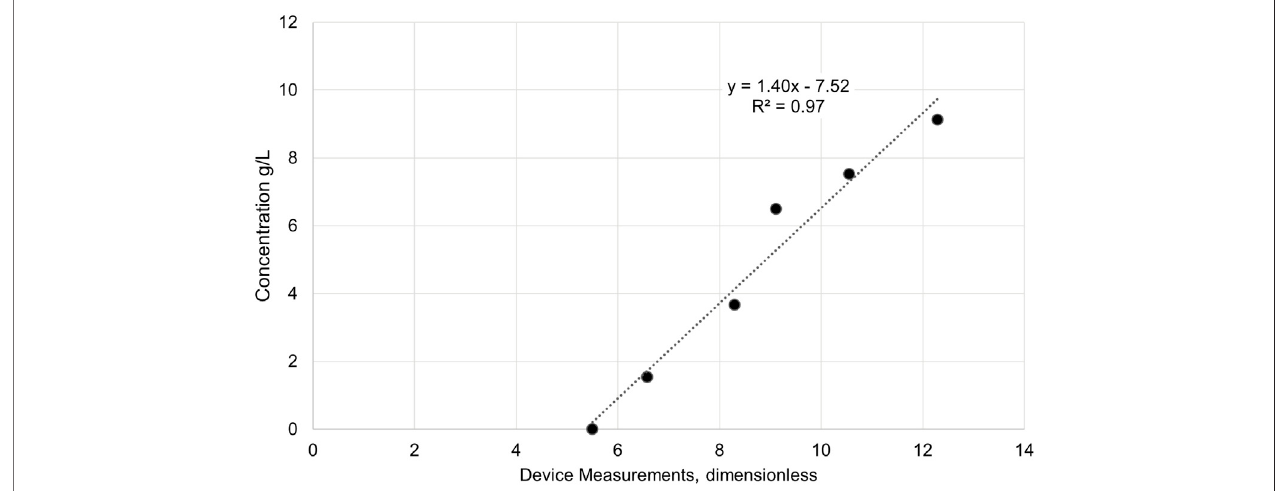
FIGURE 6 | The equation for the inversion of the fl uorometer measurements to PE concentrations.